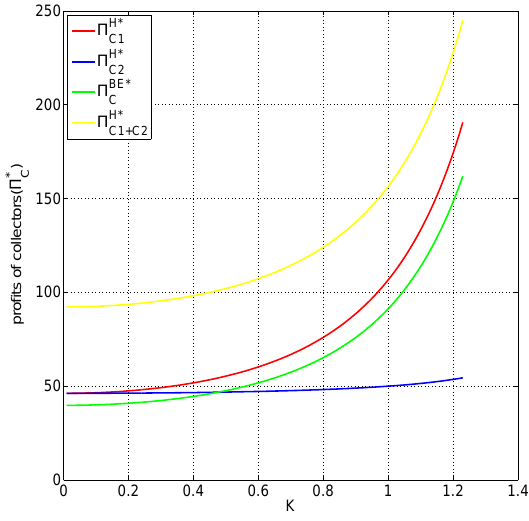
Figure 11. The influences of K on the collector’s profit Π C